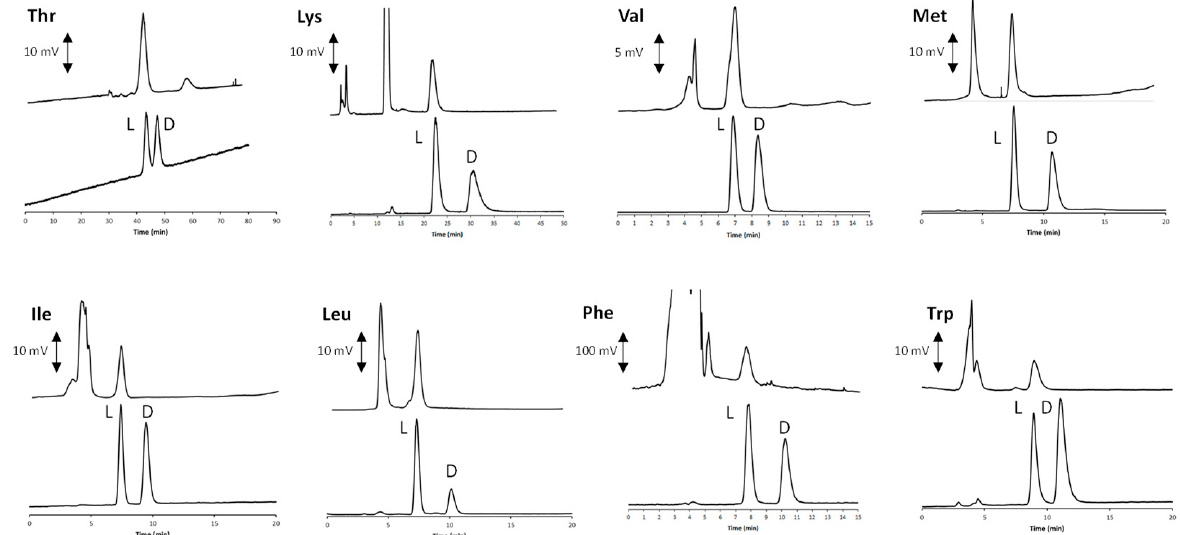
Figure 3. Chromatograms of all the eight AAs contained in the food supplement obtained with the optimized enantioselective analysis conditions. In each inset, bottom chromatograms refer to the analysis of the standard racemic of enantiomeric mixture, while upper chromatograms are related to the real samples after the off-line collection of the peaks from the achiral IP-RP analysis. The applied experimental conditions correspond to those obtained with mobile phase “b” in Table 3. The analysis of Thr was performed with a 0.1 mL/min flow rate, while all the remaining AAs were analyzed at 0.7 mL/min.